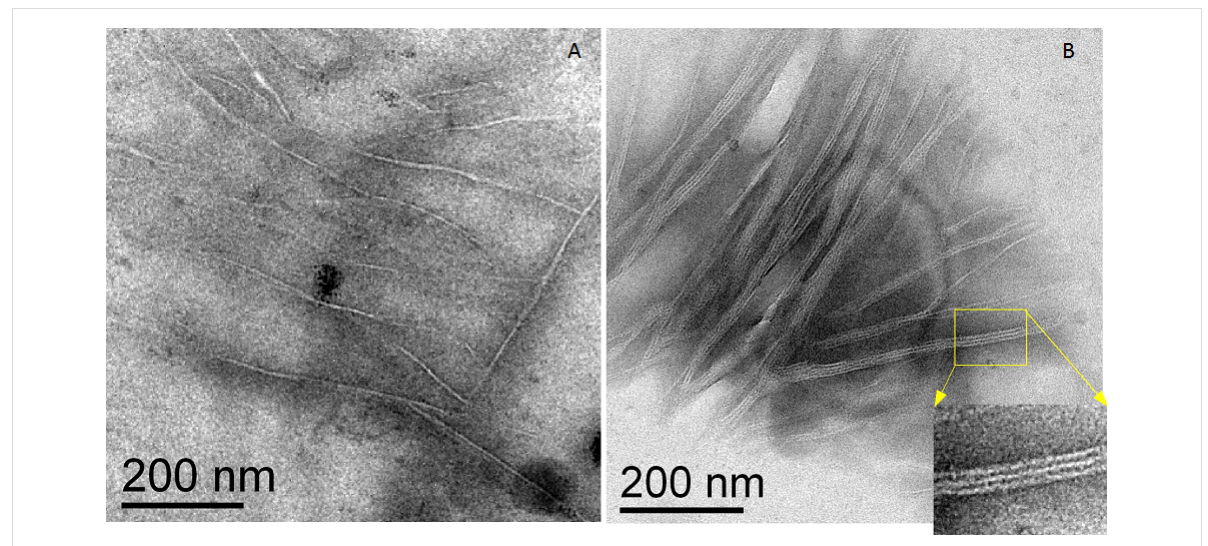
Figure 1: TEM images of A β 40 fibrils observed after two days of storage. Individual fibril and ribbon-like structures with a branched arrangement are observed in correspondence of a poor (A) and rich fibrillar area (B). The inset shown in (B) is a magnification of a ribbon-like structure consisting of three individual fibrils. The wide of a single filament is around 5 nm.